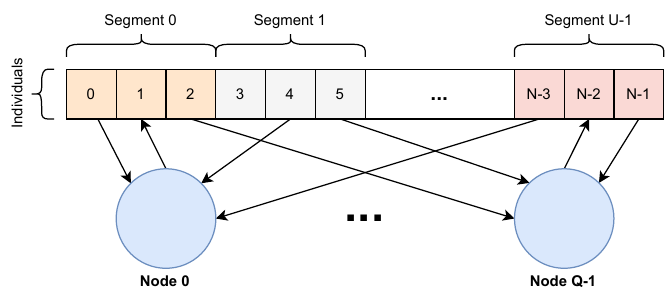
Figure 4. Pool model for distributed genetic